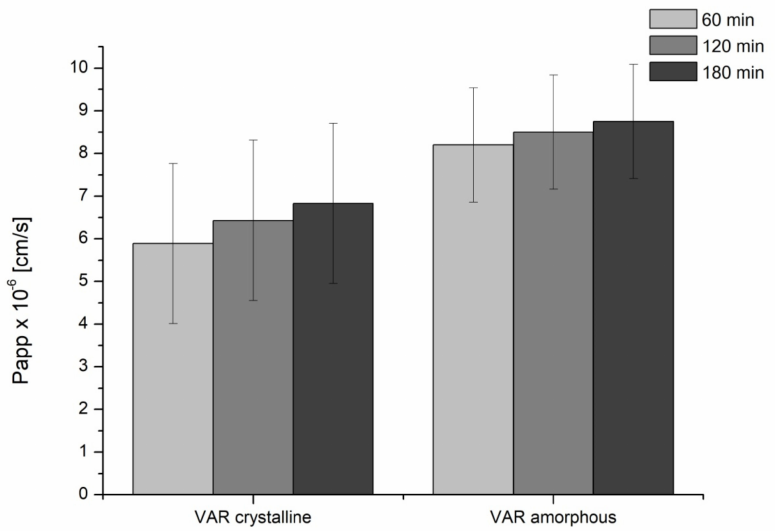
Figure 6. Apparent permeability coefficients (P app ) of amorphous and crystalline forms of VAR.